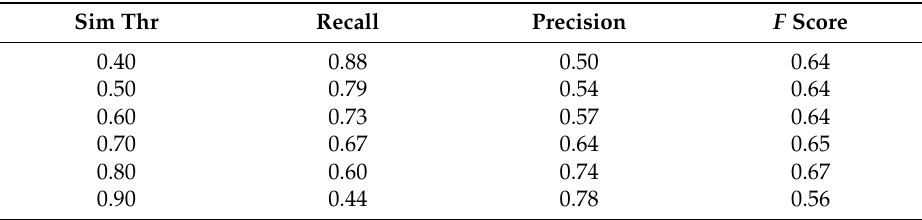
Table 4. Results for different similarity thresholds.